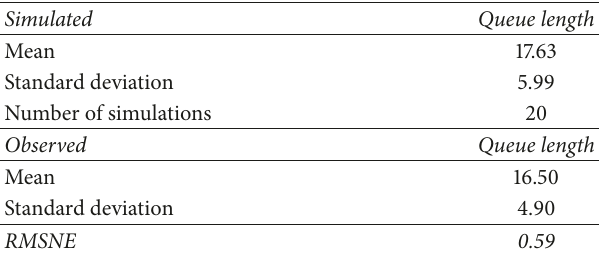
Table 11: Comparison between field-measured and simulated queue lengths in Scenario